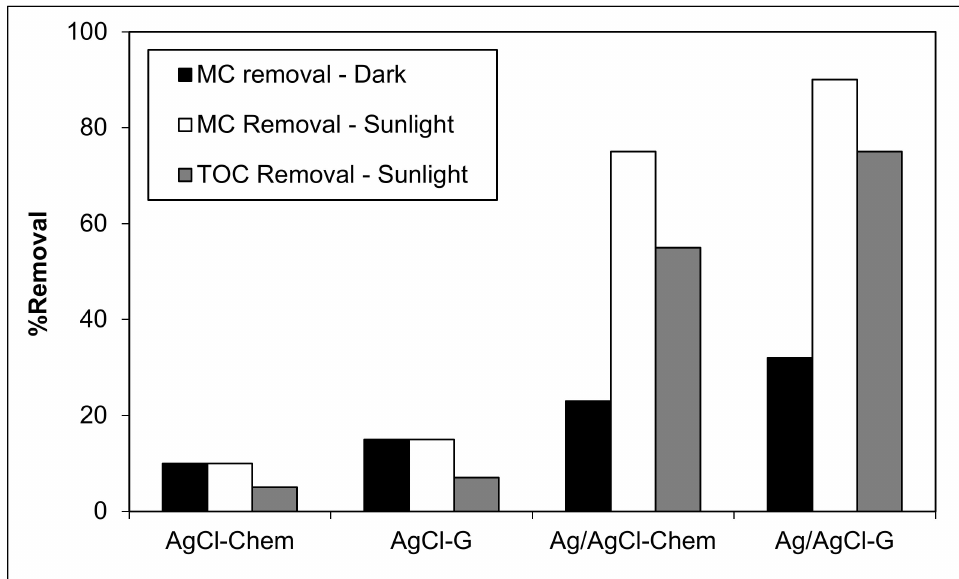
Figure 6. Plasmonic photocatalytic removal of methylthioninium chloride (MC) and total organic carbon (TOC) in sunlight or darkness using classically-prepared nanoparticles (AgCl-chem and Ag/AgCl-chem) and those synthesized using garlic extract (AgCl-G and